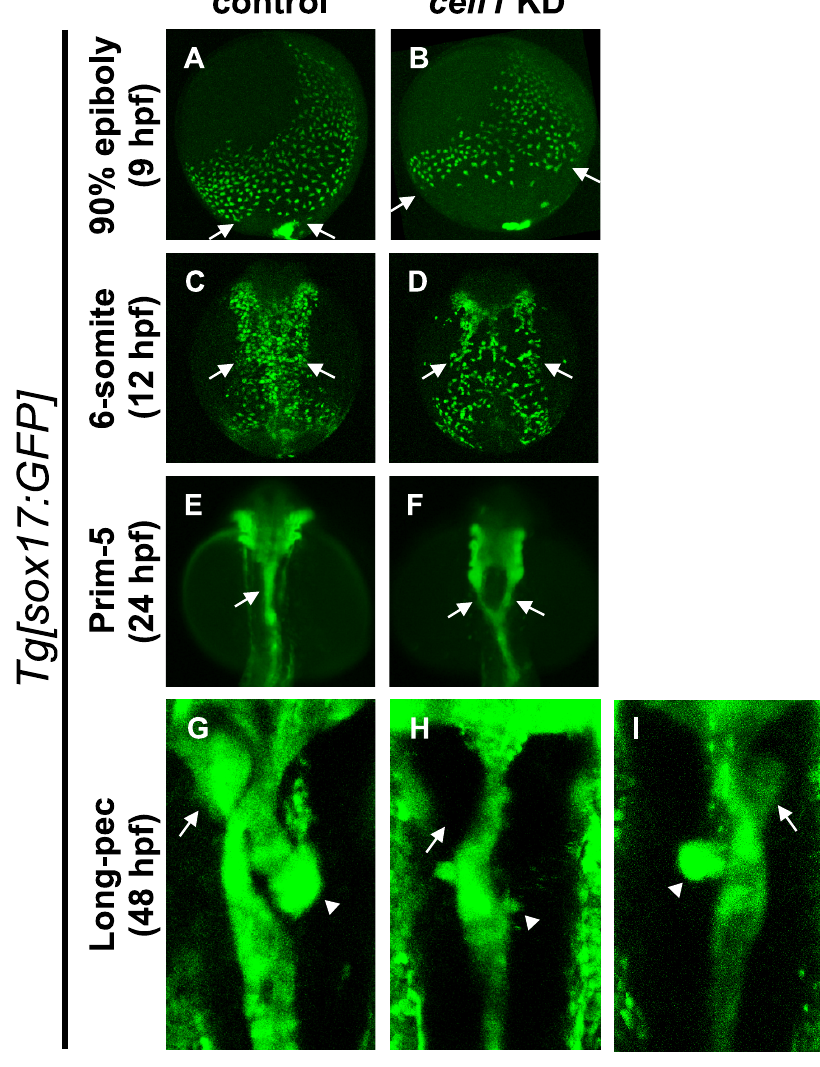
Figure 1. Knockdown of celf1 leads to defects in endoderm-derived organs. ( A – D ) Lateral views of Tg [ sox17:GFP ] transgenic embryos at 9 hpf ( A , B ). Dorsal views of the mid-trunk region of Tg [ sox17:GFP ] transgenic embryos at 12 hpf ( C , D ). Anterior to the top. The migration of GFP-expressing endoderm cells to the dorsal midline was delayed in celf1 KD embryos. Arrows in panels A, B and C, D point at the caudal and lateral edges of endoderm cells, respectively. Panels A and B are frames of supplementary movies 1 and 2, respectively. ( E , F ) Dorsal views of the pharyngeal and foregut regions of Tg [ sox17:GFP ] transgenic embryos at 24 hpf. Anterior to the top. celf1 KD embryos showed a splitting of the anterior gut (arrow). ( G – I ) Dorsal views of the mid-trunk region of Tg [ sox17:GFP ] transgenic embryos at 48 hpf. Anterior to the top. Signs of liver buds (arrows) and pancreas buds (arrowheads) were lost or lower. celf1 KD embryos resulted in defects of endoderm-derived organs ( H , I ) and left-right patterning ( I